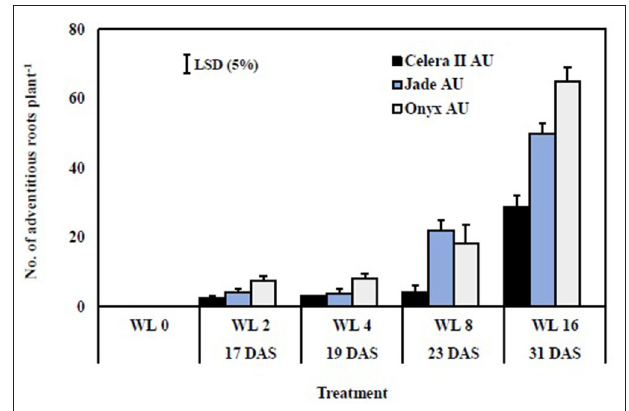
FIGURE 6 | Number of adventitious roots after different waterlogging durations. W0, drained control; WL2, waterlogging for 2 days; WL4, waterlogging for 4 days; WL8, waterlogging for 8 days; WL16, waterlogging for 16 days. Adventitious roots did not form on plants in the drained controls. Harvest occurred at 17 DAS (WL2), 19 DAS (WL4), 23 DAS (WL8), and 31 DAS (WL16). Bars are the mean ( n = 4) ± SE and LSD at P = 0.05 for the